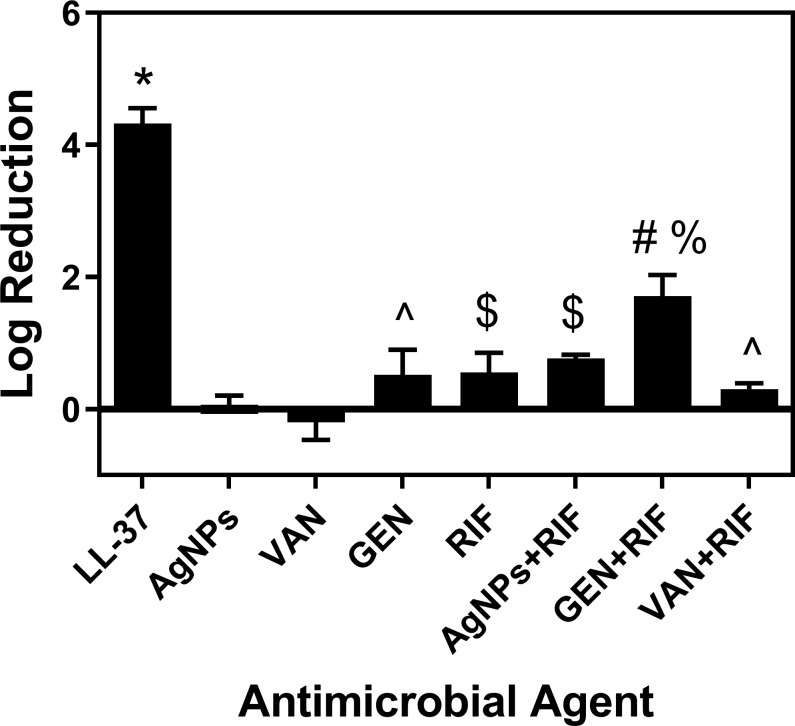
Combination treatment of antimicrobial agents with rifampin against S. aureus biofilms and comparison to LL-37 at 100 μM.Combination treatments with rifampin at concentrations of 100 μM were used to treat 24 h S. aureus biofilms for 60 min. The combination of GEN+RIF was the most significant combinatory treatment investigated, with a log reduction of 1.71. In addition, all antimicrobial agents investigated in this study were displayed at a concentration of 100 μM, where it was observed that LL-37 had the greatest log reduction against S. aureus biofilms. * Statistically significant from AgNPs, VAN, GEN, RIF, AgNPs+RIF, GEN+RIF, VAN+RIF; # statistically significant from AgNPs, VAN, GEN, RIF, AgNPs+RIF, VAN+RIF; $ statistically significant from AgNPs, VAN; ^ statistically significant from VAN; % statistically significant from the combination of GEN and RIF.